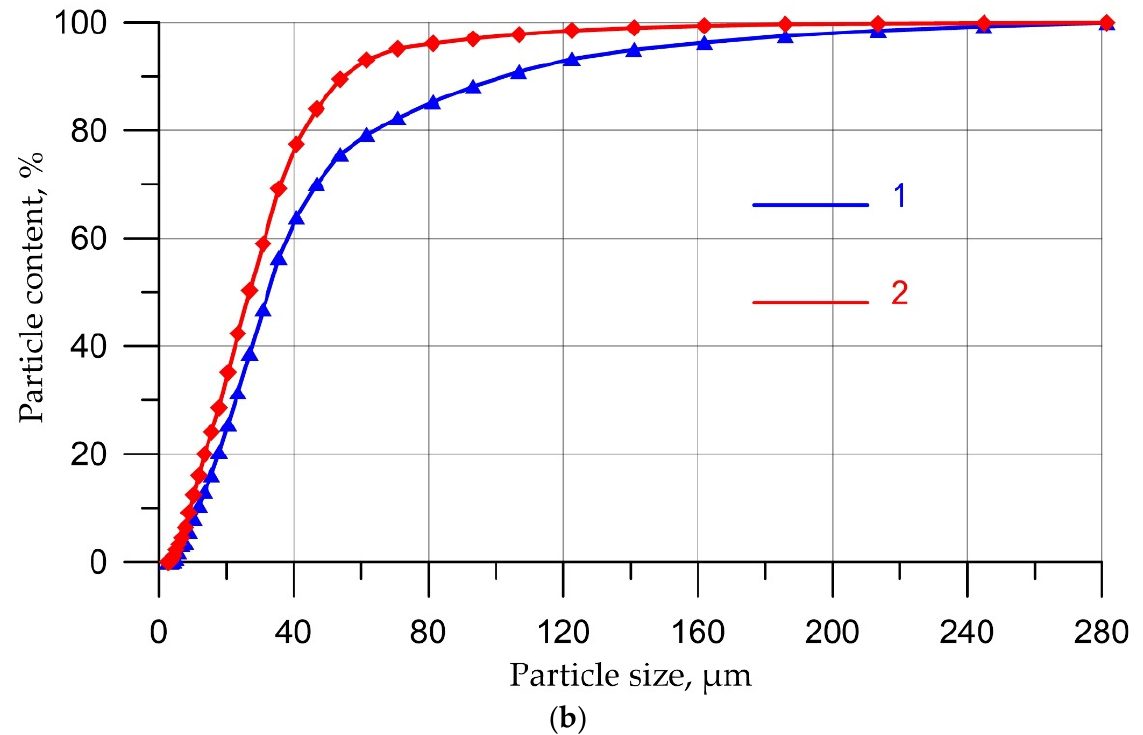
Figure 1. Graphical distribution of fly ash (FA) particles: ( a ) particle distribution, ( b ) cumulative curve, 1—before grinding; 2—after grinding.